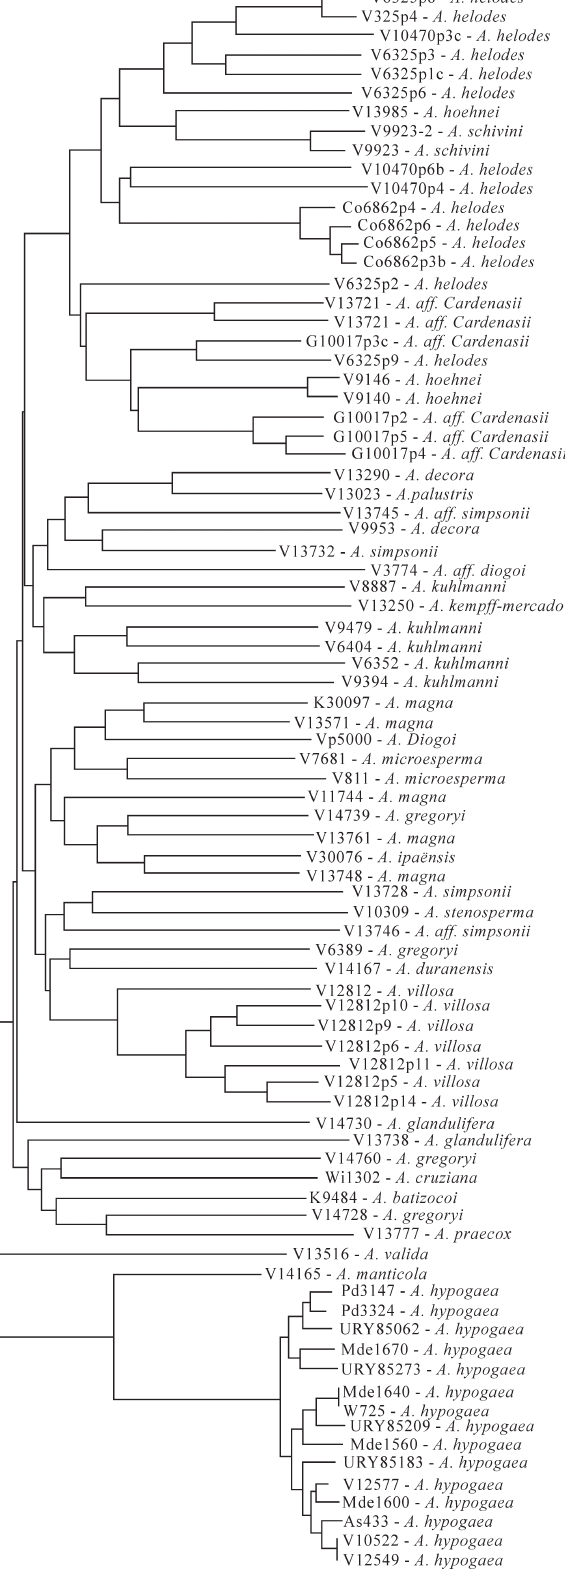
Figure 2 - Dendrogram showing the relationship between 83 plants of 60 genus Arachis accessions. The dendrogram was based on the analysis of 14 microsatellite loci.